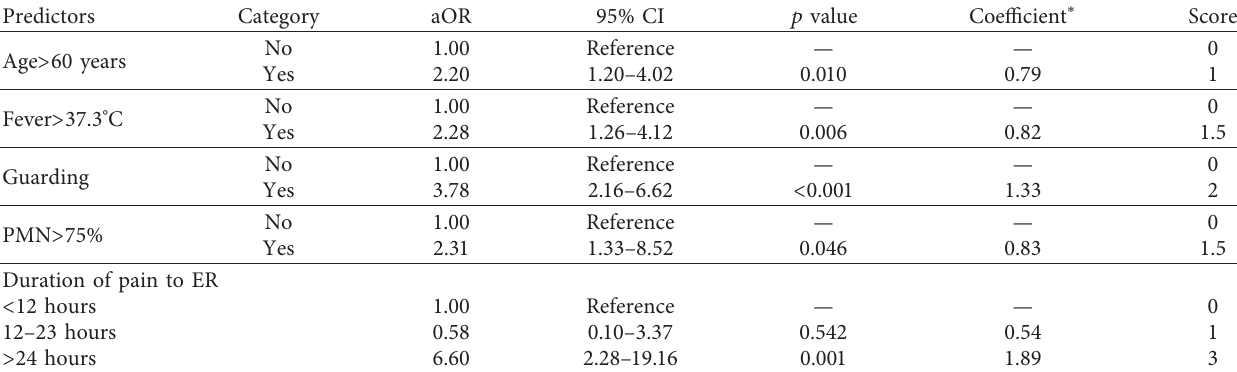
Table 2: Predictors of ruptured appendicitis and the assigned item score in cases of suspected acute appendicitis. Predictors